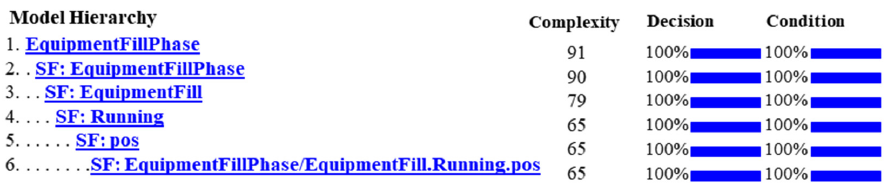
Figure 11. Test Metrics Summary displaying the Model Hierarchy and the associated Complexity, Decision and coverage metrics for each model element.